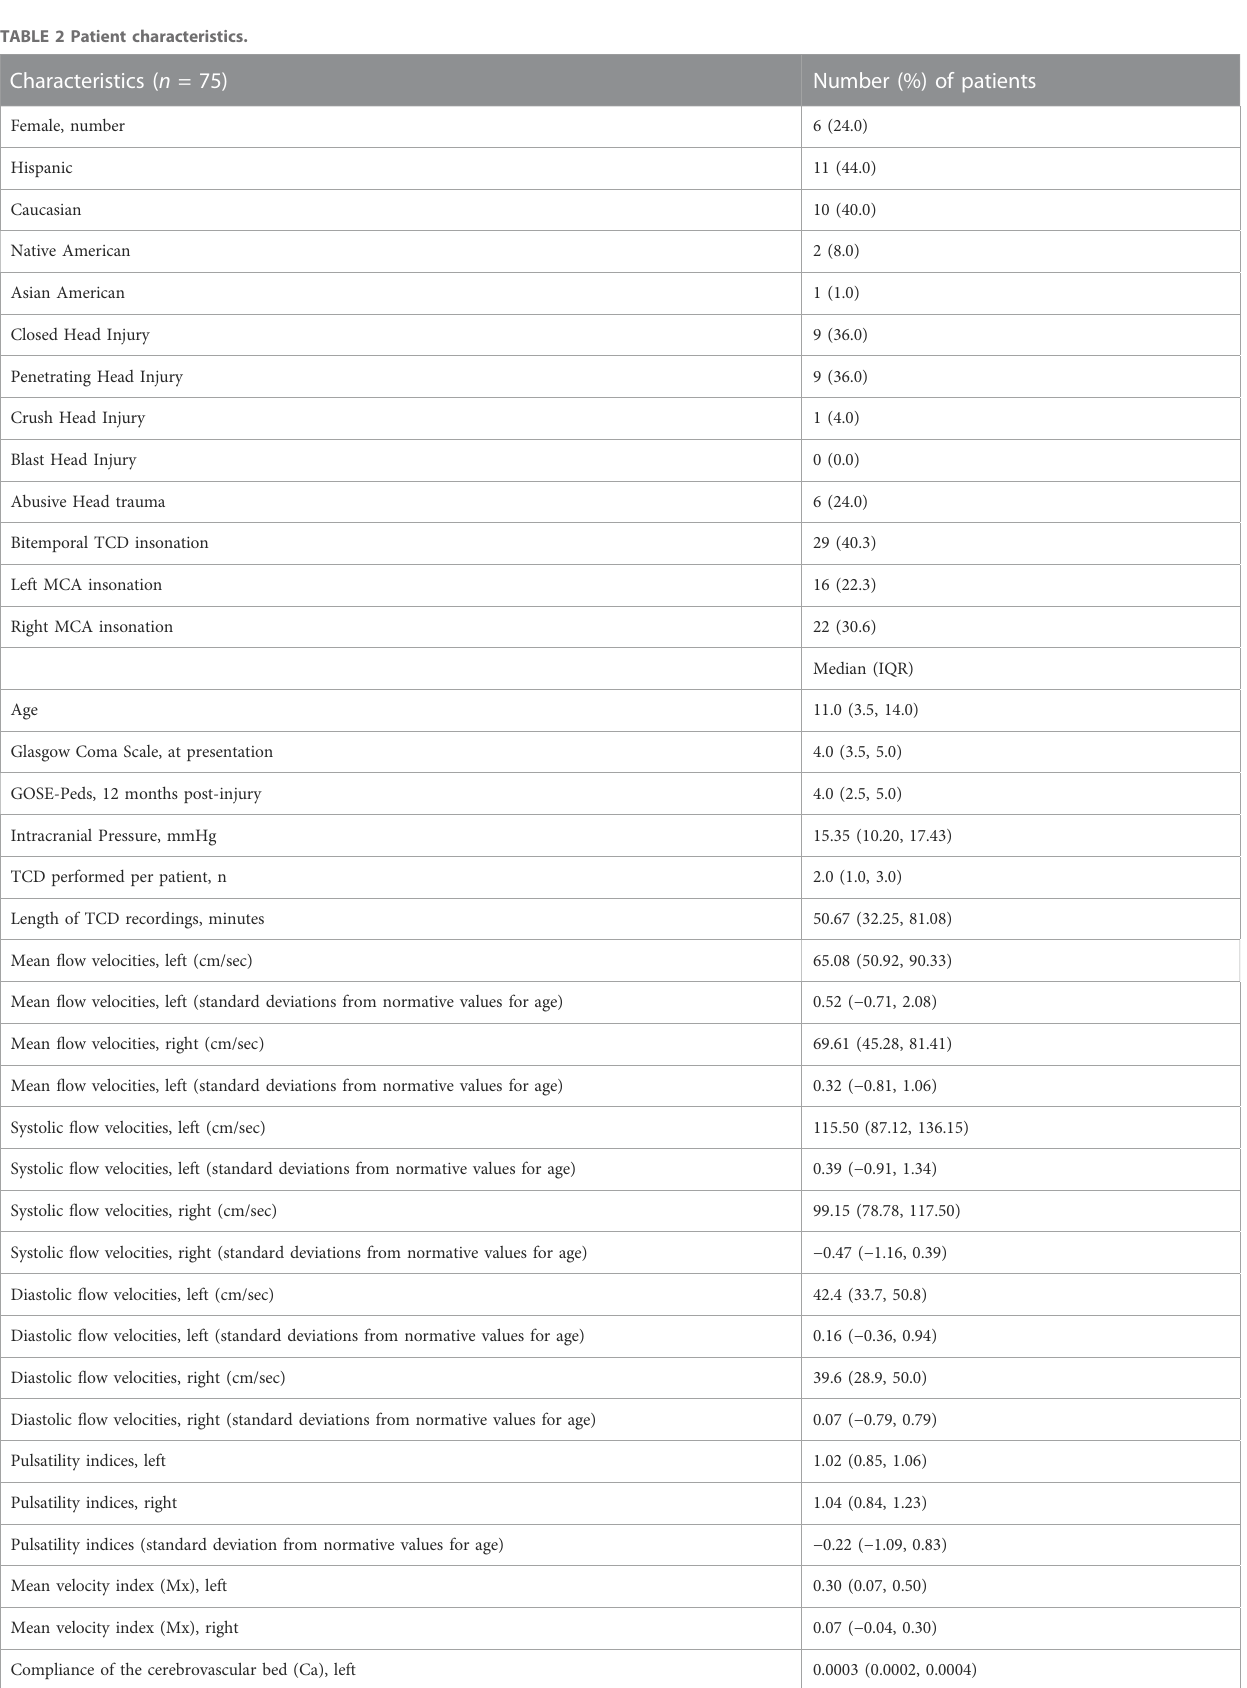
TABLE 2 Patient